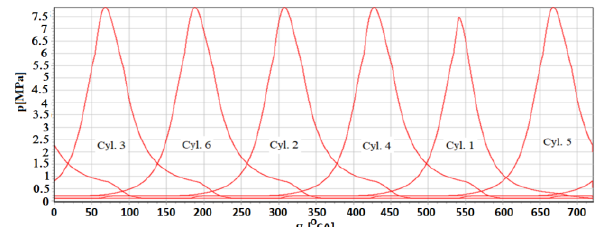
Fig. 1. The waveform of the indicated pressure in the engine cylinders as the function of the rotation angle of the crankshaft (cylinder no. 1 is sup- plied with an amount of fuel reduced by 80%)